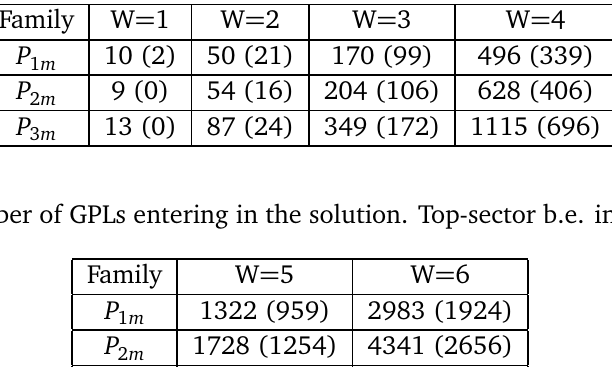
Table 1: Number of GPLs entering in the solution. Top-sector b.e. in parenthesis.